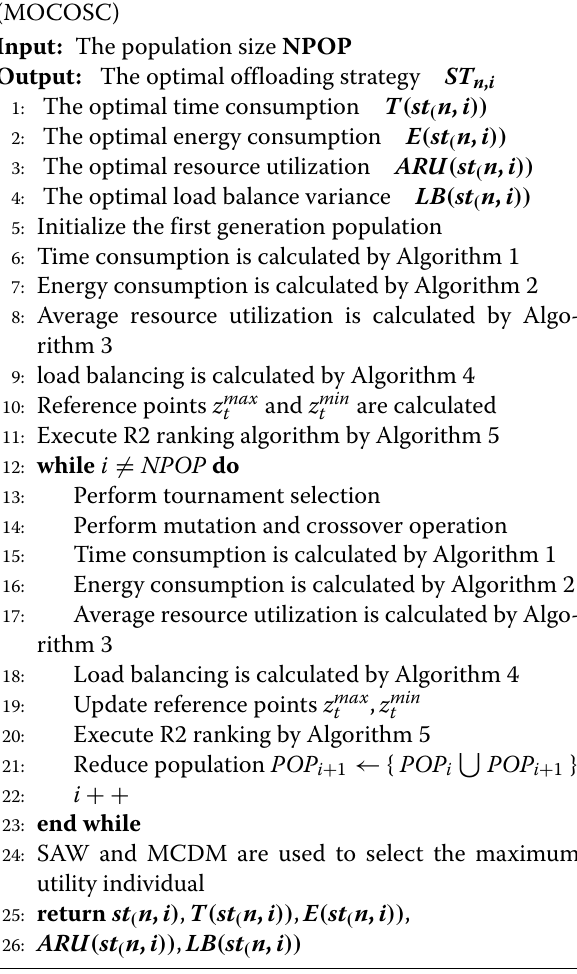
Algorithm 6 A multi-objective collaborative optimization for smart